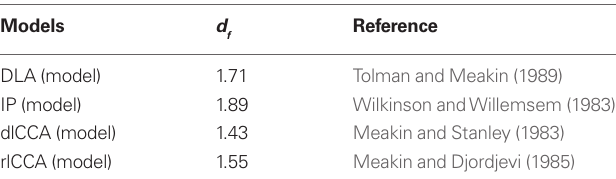
from different computational models. f